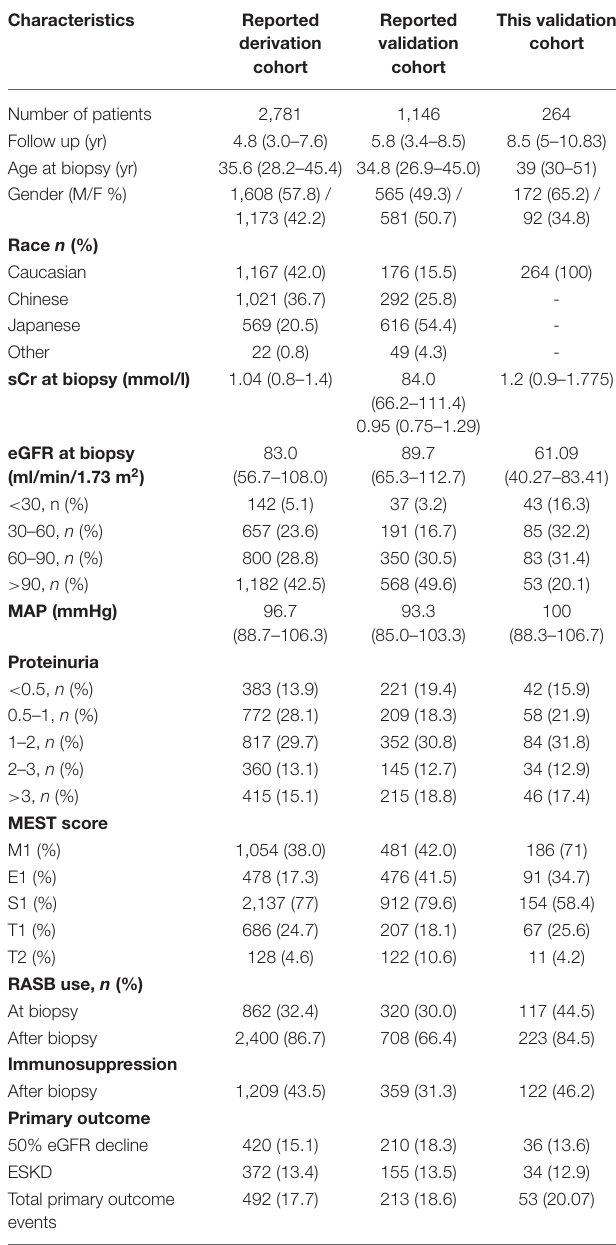
TABLE 1 | Comparison of clinical and histological characteristics in the current and previously reported